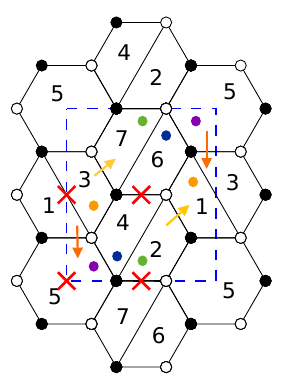
Figure 22 . The dimer of the PdP 4 orientifold point singularity. Spots with the same color are mapped into each other (and so the corresponding